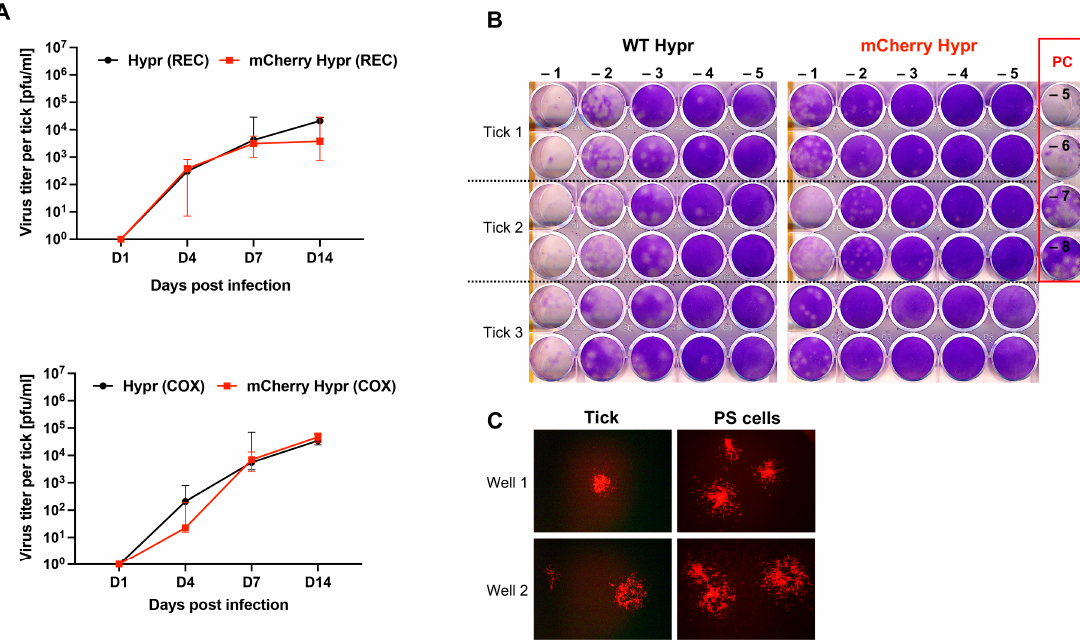
Figure 3. Detection of viruses in experimentally infected ticks by plaque assay. ( A ) Graphs show median viral titer per single intrarectally (REC) and transcoxally (COX) inoculated tick. Five ticks were individually assayed per virus and time point. Error bars show 95% confidence intervals. ( B ) Representative assay showing plaques of the viruses in serially diluted ( − 1 to − 5) tick REC samples (n = 3) at 14 dpi. PC-positive control, PS cells infected with serial dilutions of a control wild-type Hypr TBEV are also outlined in red. ( C ) Representative images of fluorescent mCherry Hypr plaques visualized in PS cells infected with mCherry Hypr directly (PS cells) and in PS cells infected with homogenate of a mCherry Hypr-infected tick at 23 dpi (Tick). Wells 1 and 2 indicate replicate wells in a culture